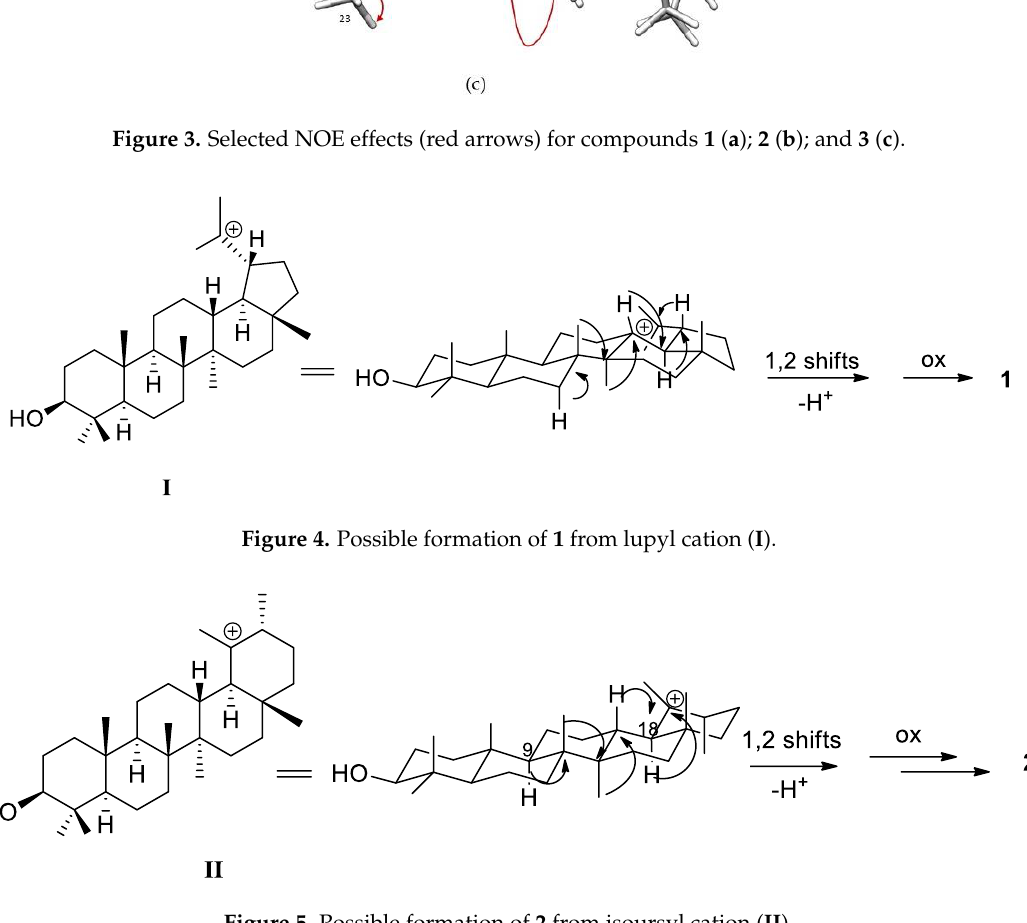
Figure 5. Possible formation of 2 from isoursyl cation ( II ).